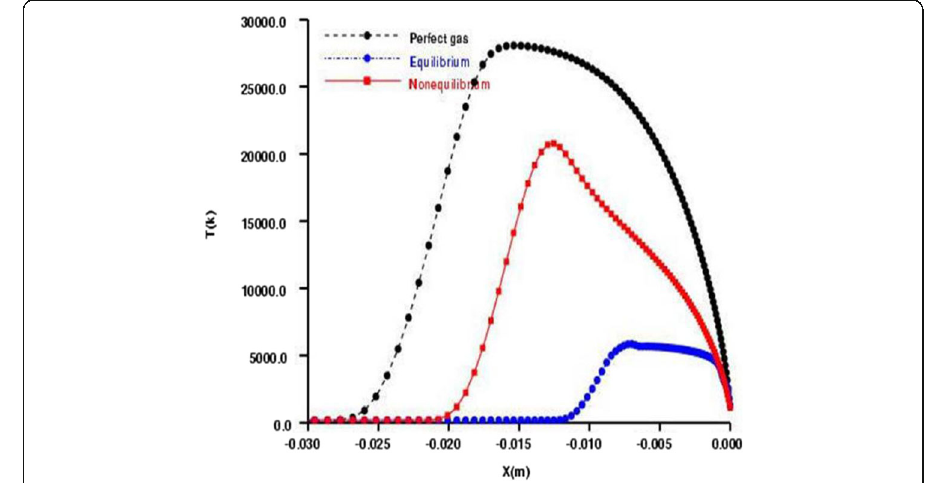
Fig. 5 Translational temperatures distributions along stagnation